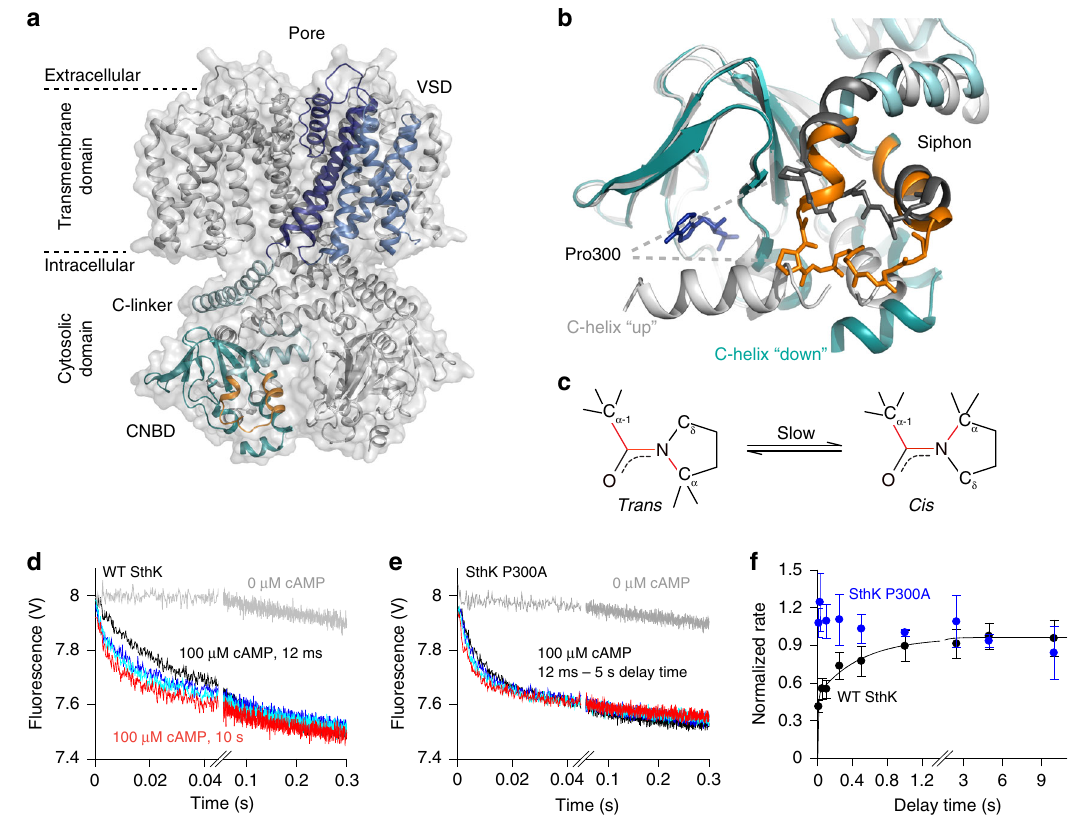
Fig. 1 Structural and functional overview of SthK. a SthK ion channel (PDB: 6CJU) in surface (transparent gray) and cartoon representation. The separate domains of one monomer of the protein are shown in different colors with voltage-sensing domain (VSD): blue, pore domain: purple, C-linker: light green, and CNBD: cyan. Siphon is highlighted in orange. b Overlay of the CNBD of full-length SthK (PDB: 6CJU) in cyan and the isolated domain (PDB: 4D7T) in gray, with the siphons highlighted in orange and black, respectively. The central loop has residues in stick representation. cAMP is in stick representation (blue) for full-length SthK. c trans and cis conformer of a prolyl bond. d , e Quenching kinetics from the Tl + fl ux assay for WT ( d ) and P300A ( e ) SthK. Samples were incubated with 0 µ M cAMP (gray), and with 100 µ M cAMP for 12 ms (black), 100 ms (blue), 500 ms (cyan) and 10 s (red, 5 s for SthK P300A). f Tl + fl ux rates (Eqs. (2) and (3)) obtained from kinetics as shown in ( d ) and ( e ) for WT SthK (black, n = 8 independent experiments) and SthK P300A (blue, n = 5 independent experiments) as a function of the delay time. Symbols represent mean ± S.D. The activation time course (black curve) was fi tted according to a double exponential function with amplitudes a and rate constants k of a 0.5 s − 1 . Source data are provided as a Source Data fi